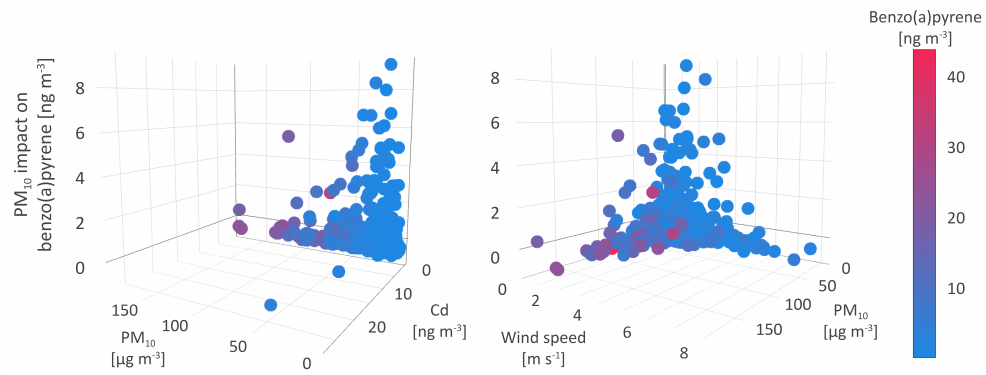
Figure 9. Particulate matter impact on